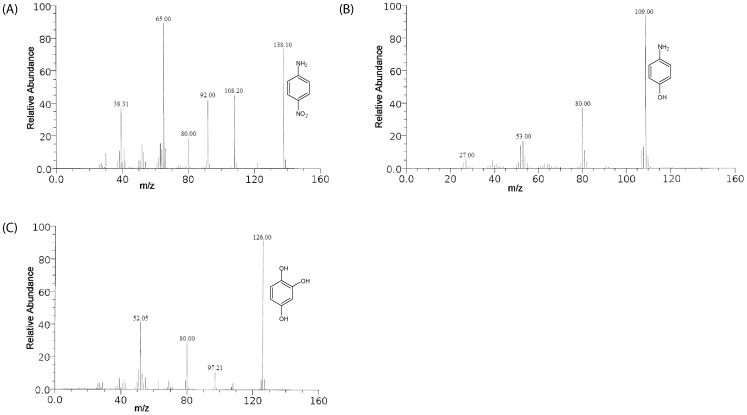
Mass-fragmentation patterns of the metabolites identified by GC-MS analysis during the degradation of MNA by resting cells of Pseudomonas sp. strain FK357.(A) Mass-fragmentation patterns of 4-NA (B) Mass-fragmentation patterns of 4-AP, and (C) Mass-fragmentation patterns of BT.